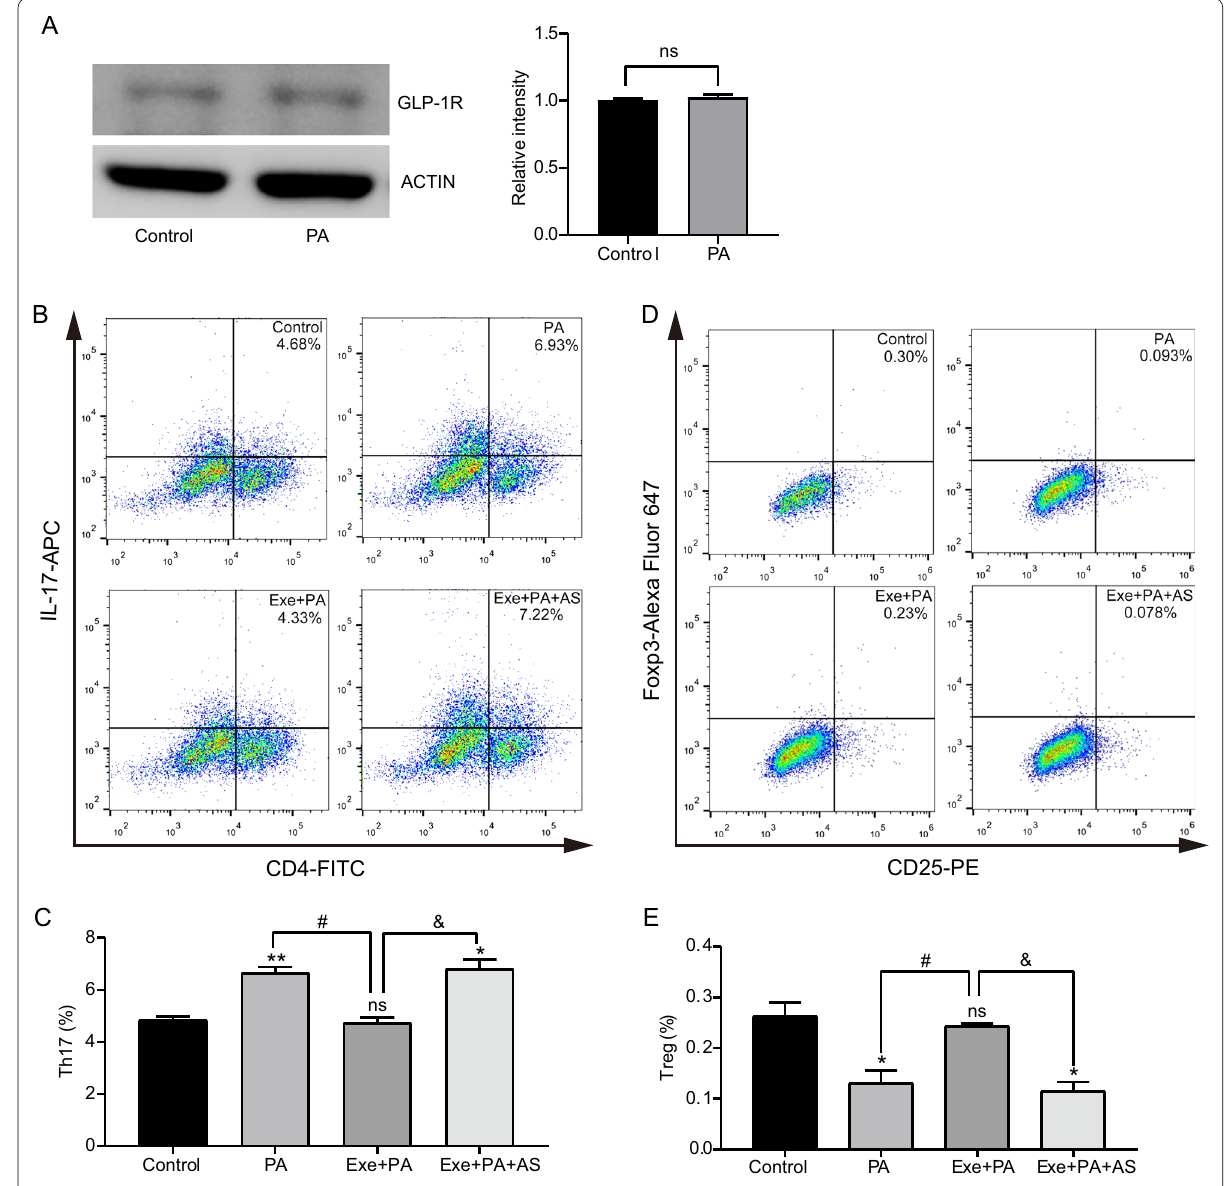
Fig. 4 Effects of exenatide on Th17/Treg proliferation in vitro. A The expression of GLP-1R in PBMCs from C57BL/6 J mice by western blot. Representative image and gray value analysis of GLP-1R from Control and palmitate (PA) groups. Data are presented as mean independent experiments. ACTIN was used as a loading control. Naïve CD4 T cells collected from C57BL/6 J mice were cultured under Th17/ + Treg-inducing conditions with palmitate (PA), exenatide plus palmitate (Exe PA) and exenatide, palmitate plus FxoO1 inhibitor AS1842856 + (Exe PA AS). B Representative flow cytometric plots of Th17 cells from different groups. C Statistical analysis of the percentage of Th17 cells + + in different groups. D Representative flow cytometric plots of Treg cells with CD4-FITC, CD25-PE and Foxp3 staining. E Statistical analysis of the percentage of Treg cells. Data are presented as mean SEM of three independent experiments. ** P < 0.01, * P < 0.05 vs control group; # P < 0.05 vs PA ± group; & P < 0.05 vs Exe PA group; ns P > +